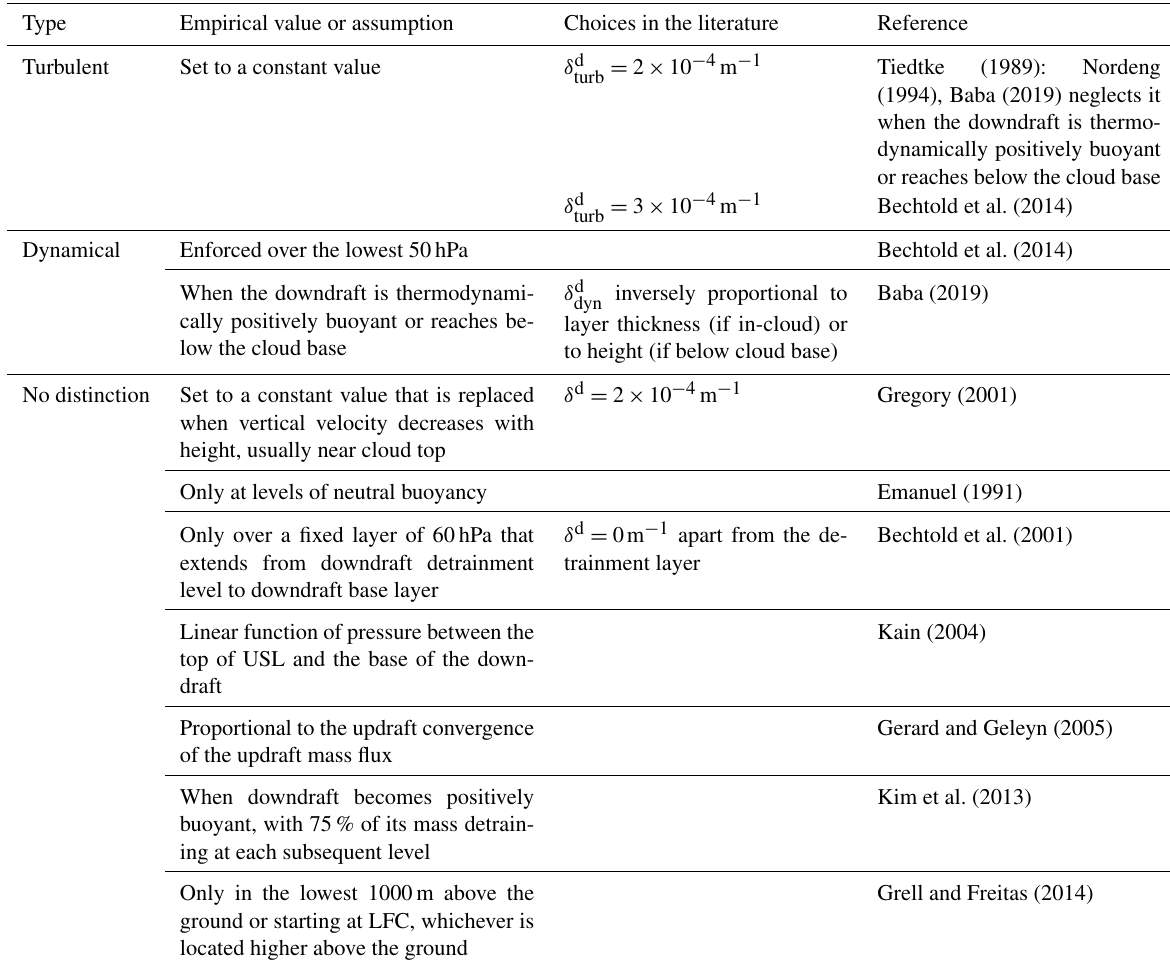
Table 8. A sample of empirical values and assumptions used in the parameterization of detrainment in the downdraft.